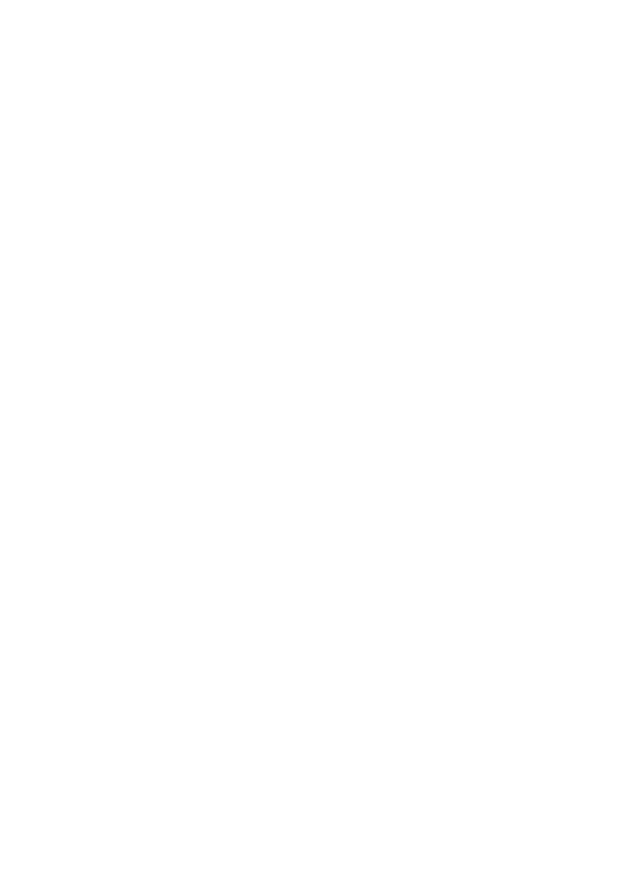
Figure 5. Calculation procedure .